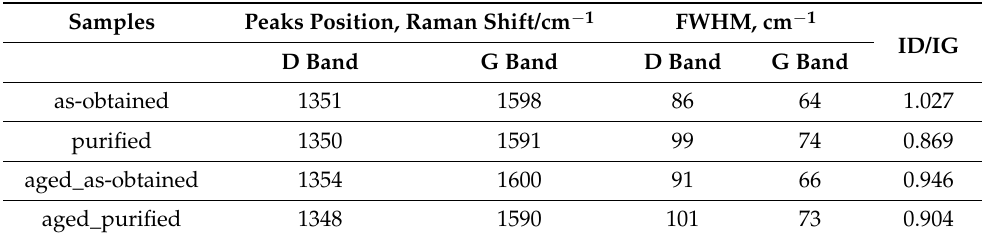
Figure 7. Raman spectra of GO samples tested in this study. Table 2. Raman shift positions, full width in the high maximum (FWHM) and intensity ratio (ID/IG) of GO films.